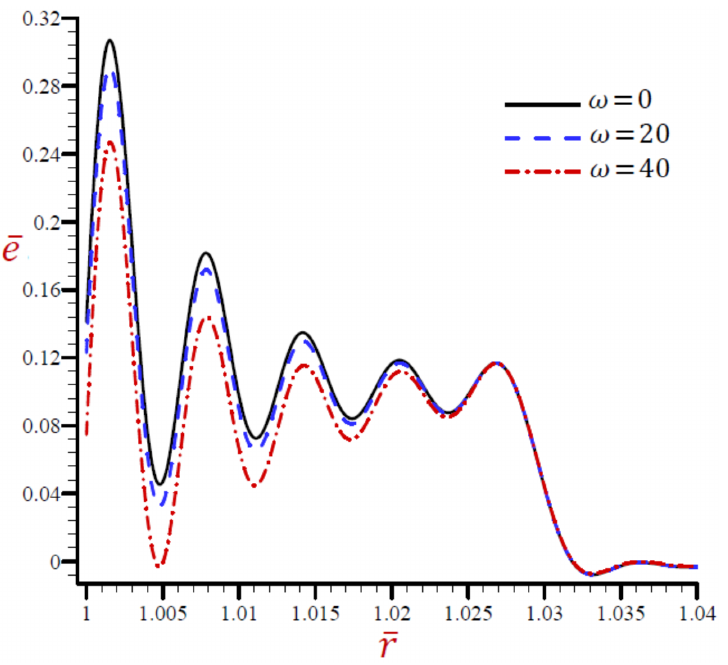
Figure 8. Effect of ω on dilatation e across the radial direction of the cylindrical cavity utilizing the RDPL model.